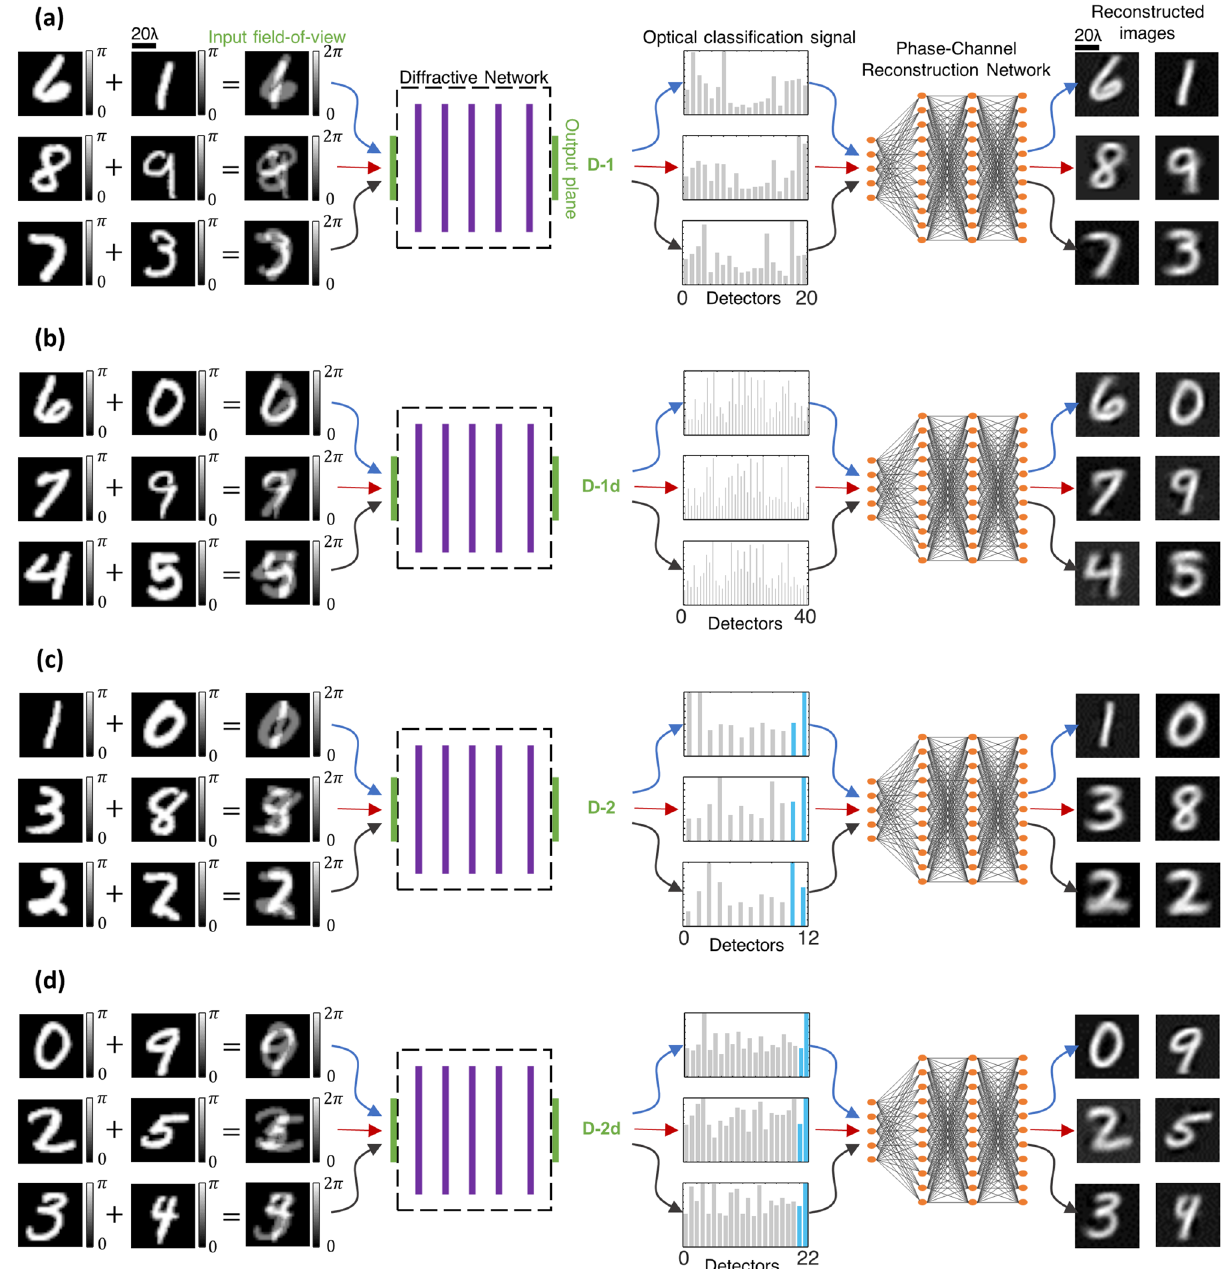
Figure 6. Reconstruction of spatially overlapping phase images using a diffractive optical front-end (encoder) and a separately trained, shallow electronic neural network (decoder) with 2 hidden layers. The front-end diffractive optical networks are ( a ) D 2 NN-D1, ( b ) D 2 NN-D1d, ( c ) D 2 NN-D2, and ( d ) D 2 NN-D2d, shown in Figs. 2a, 3a, 4a and 5a, respectively. The detector layouts at the output plane of these diffractive optical networks are ( a ) D-1, ( b ) D-1d, ( c ) D-2, and ( d ) D-2d with 2 M , 4 M , M + 2 and 2 M + 2 single pixel detectors as shown in Fig. 1b-d, respectively; for handwritten digits M = 10 . These four designs create a compression ratio of 39.2 × , 19.6 × , 65.33 × and 35.63 × between the input and output fields-of-view of the corresponding diffractive optical network, respectively. The mean SSIM and PSNR values achieved by these phase image reconstruction networks are depicted in Table 2 along with the corresponding standard deviation values computed over the 10 K test input images (T 2